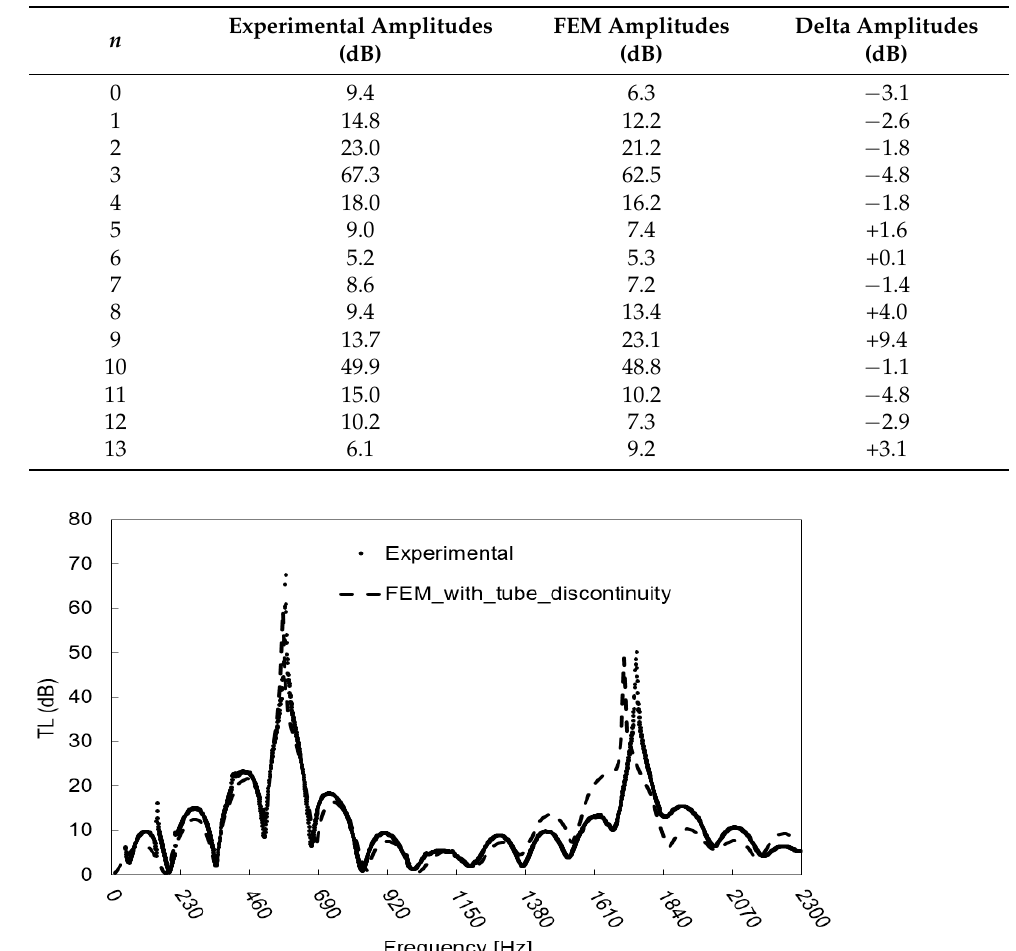
Table 8. Comparison between experimental and FEM amplitudes of model-scale scrubber with discontinuity.